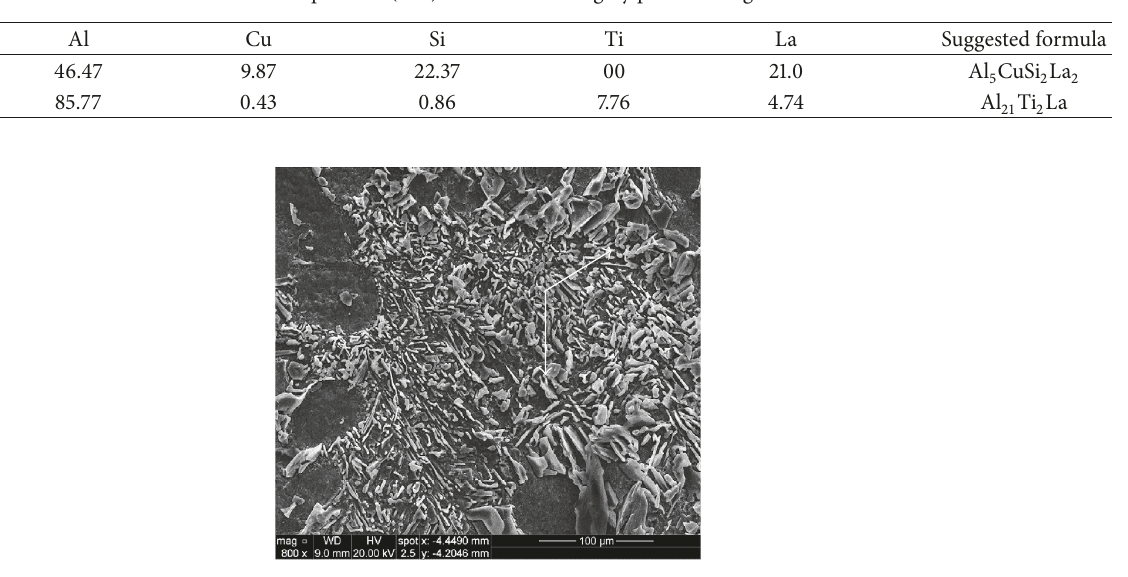
Table 3: Chemical composition (at%) of the white and grey phases in Figures 10 and 11.